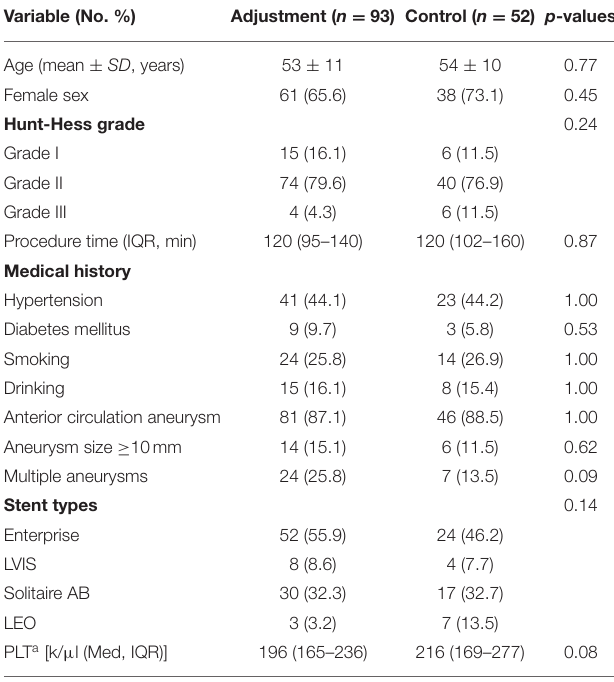
TABLE 1 | Baseline characteristics of the patients in the adjustment and control groups. Variable (No.